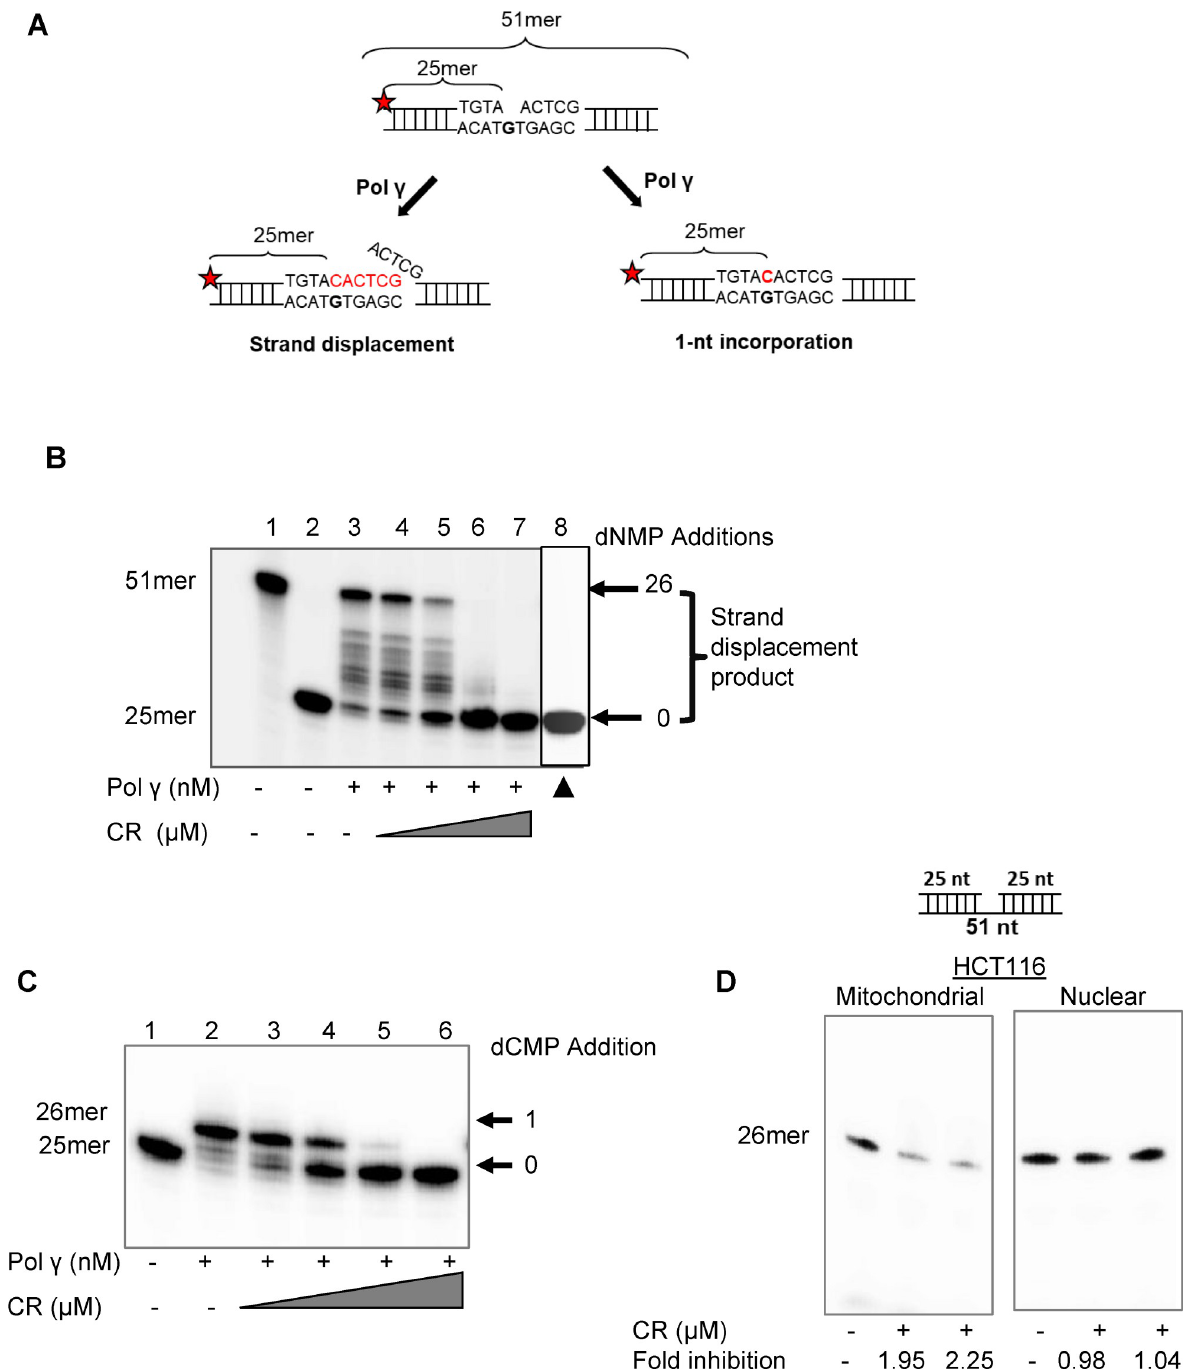
Fig 3. CR inhibits the DNA synthesis activity of purified Pol γ protein and that of mitochondrial cell extracts. (A) Schematic of the 32 P-labeled (red star) 51 bp DNA substrate containing 1-nt gap at position 26 is shown before and after Pol γ strand displacement and 1-nt incorporation activities (B) Strand displacement reactions contained Pol γ alone (40 nM; lane 3) or together with increasing concentrations of CR (lanes 4–7; 0,5, 1.25, 2.5, and 5 μ M). Lane 1, 51mer oligodeoxynucleotide; lane 2, substrate alone. ▲ , 40 nM heat-denatured Pol γ protein (lane 8). (C) 1-nt gap incorporation reactions contained Pol γ alone (40 nM; lane 2) or together with increasing concentrations of CR (0,5, 1.25, 2.5, and 5 μ M; lanes 3–6, respectively). Lane 1, substrate alone. (D) Single nucleotide DNA synthesis activity in mitochondrial and nuclear extracts treated with/without CR. Treated samples were run in